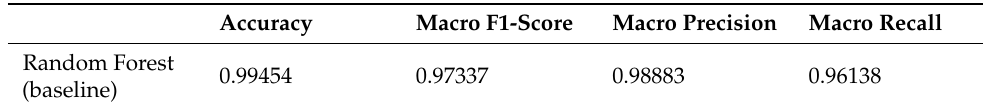
Figure 16. The R-Squared Analysis of Three Experimental Fields. Table 11. The Performance of the RF Baseline Model.